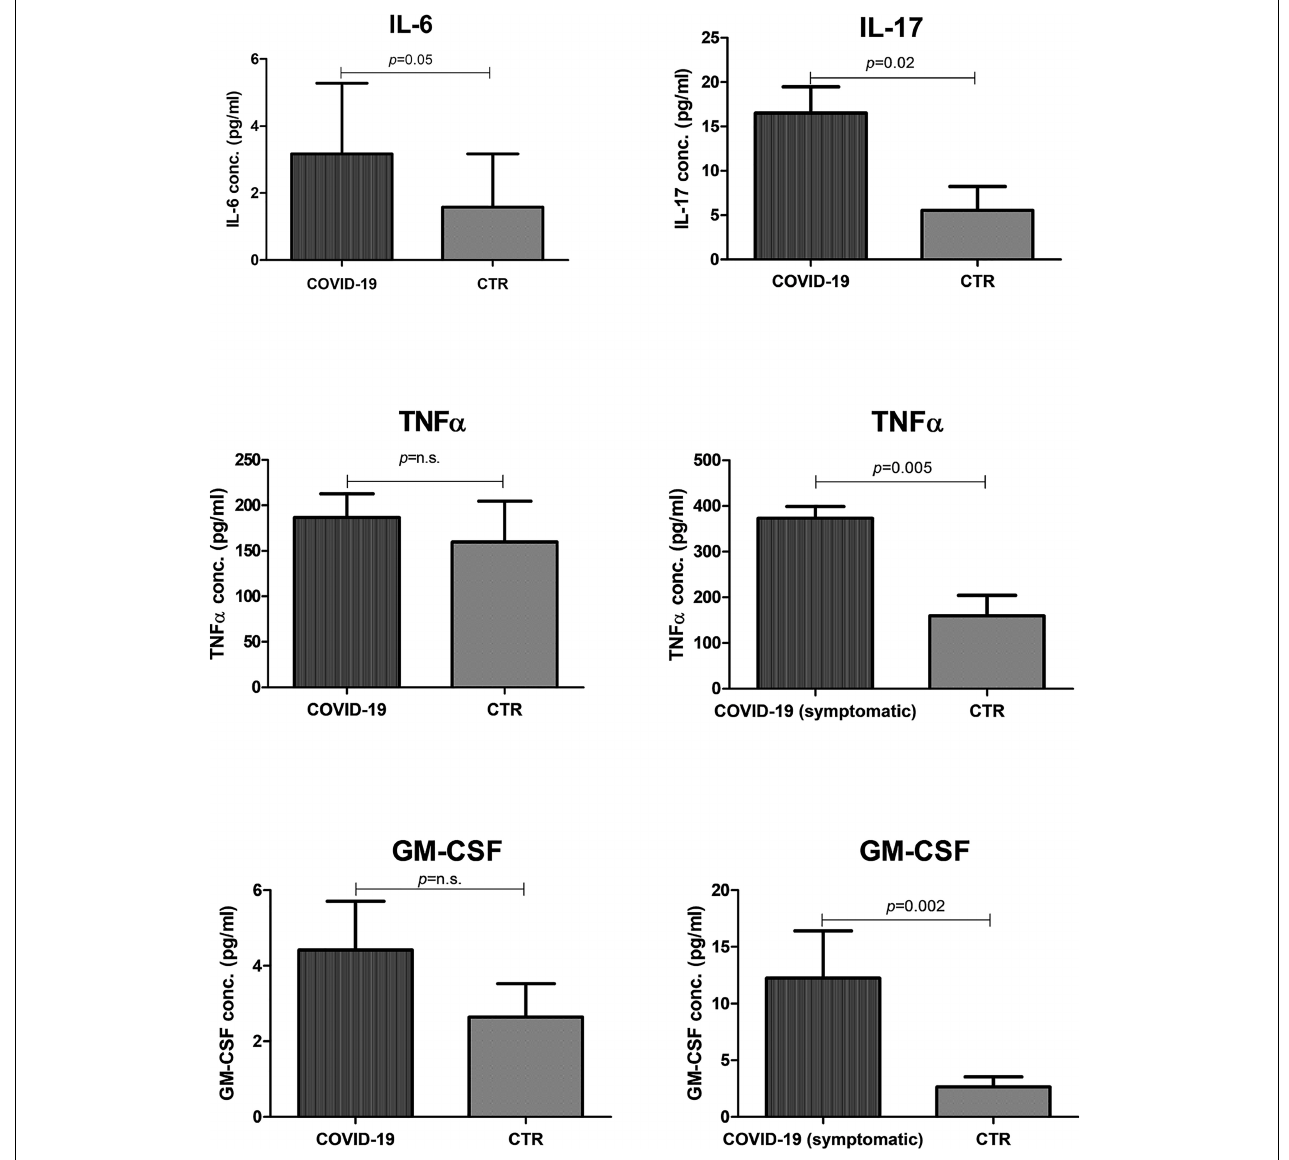
FIGURE 8 | Presence of pro-inflammatory cytokines/chemokines in the oral cavity of COVID-19 patients and controls (CTR). The results are expressed as the mean values ± SEM of the concentration (pg/ml) for each indicated